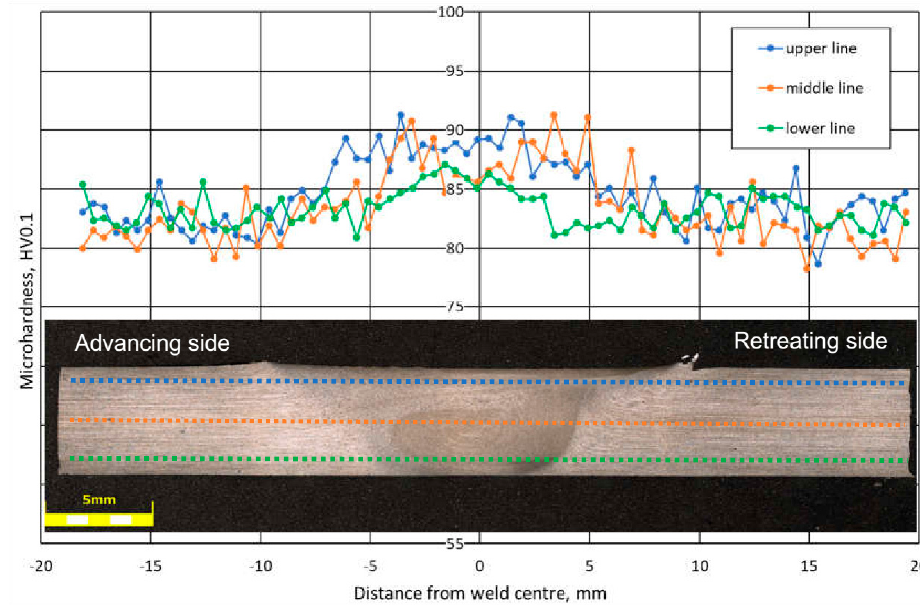
Figure 6. Microhardness values of AA5083 H111 FSW joint in the A5_5-2 sample.